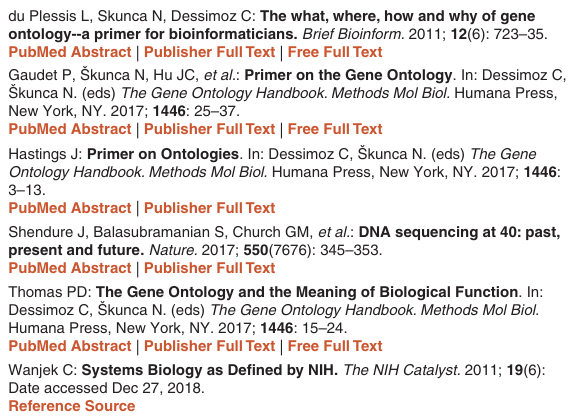
Figshare: Workbook 2. Coding of student responses to question